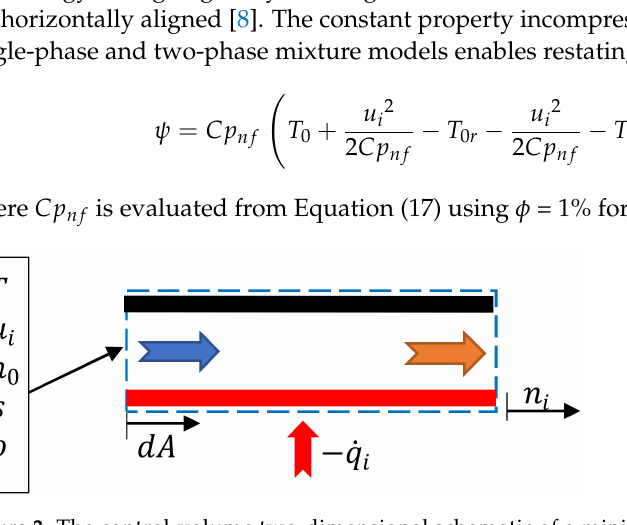
Figure 3. The control-volume two-dimensional schematic of a minichannel heat sink. The heat flux direction is indicated by the up-pointing